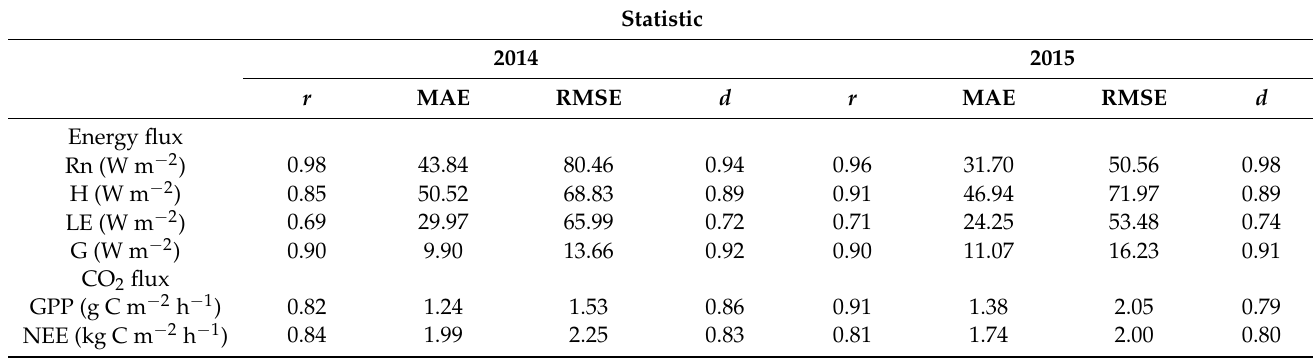
Table 3. Results of the Pearson correlation coefficient ( r ), median absolute error (MAE), root mean square error (RMSE) and Willmott’s index of agreement ( d ) between eddy covariance observations of energy and CO 2 fluxes and simulations with the parameters set after calibration for the years 2014 and